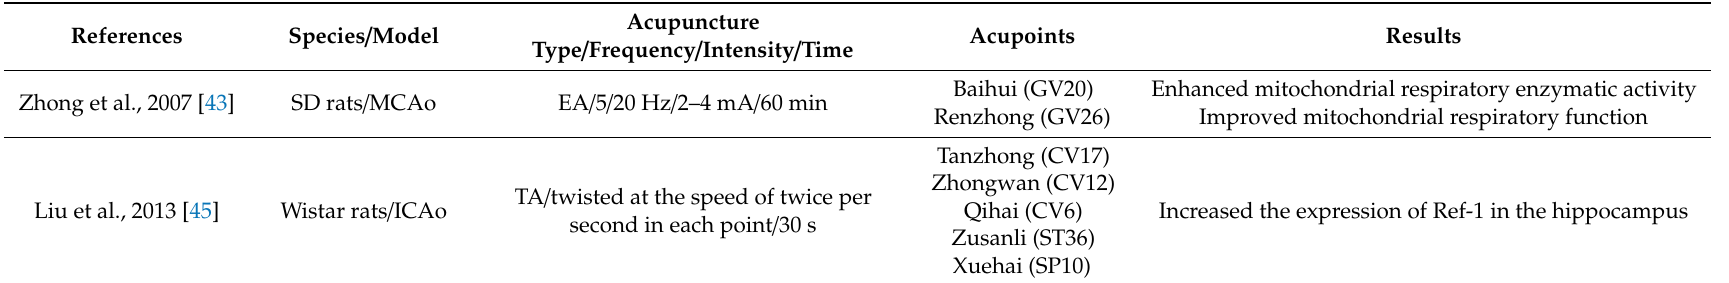
Table 3. Acupuncture repairs proteins, lipids, or DNA that have been attacked by